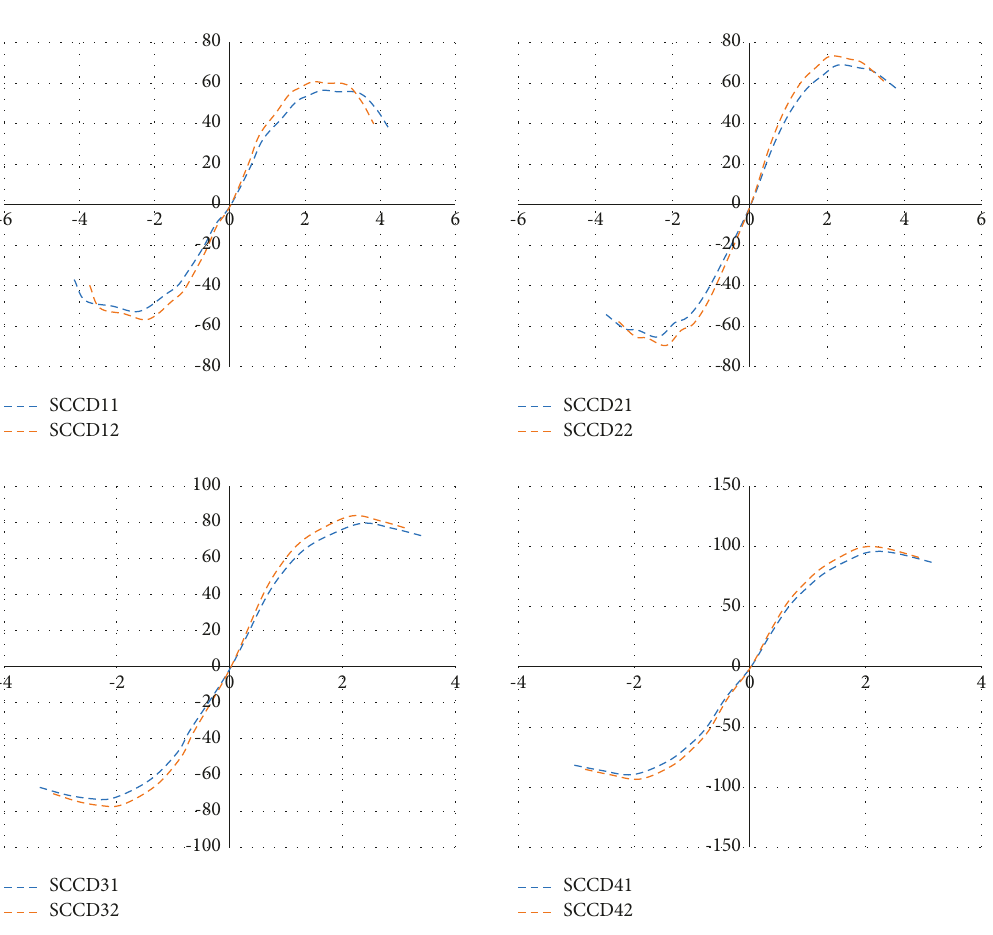
Figure 11: Backbone curve of slab-column connection with and without drop concrete grade increased from 47.7 MPa to 90 MPa, the grades. Figures 12(a) and 12(b) present the backbone/en- velope curves of slab-column connections without and without drop panels, respectively. For both slab-column connections, with and without drop panels, the slope of the curves was increased as the concrete grade increased. This implies that at the same level of drift ratio, a large lateral load was resisted by connection with larger concrete strength. As